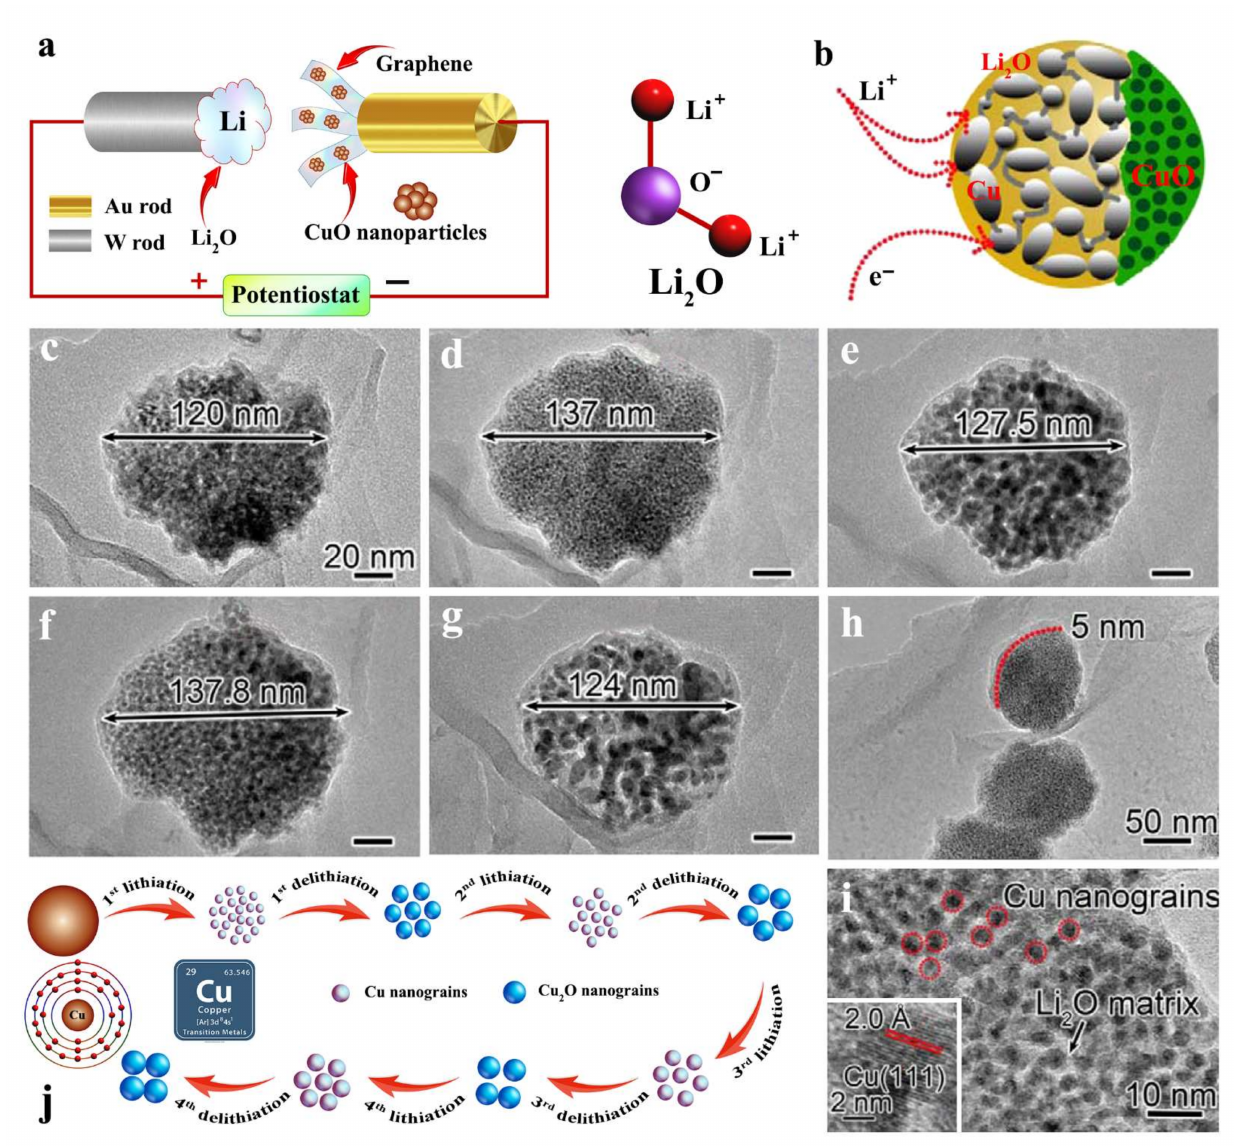
Figure 14. Morphological images of the changes occurring in pristine CuO/graphene electrode on charge–discharge cycling in a nano-LIB; ( a ) Illustration of the electrochemical setup for in situ TEM imaging, ( b ) schematic representation of the reaction front in a single CuO particle and the transport pathway for Li + ions and electrons; TEM image of ( c ) the pristine CuO nanoparticle, ( d ) the first lithiation product, ( e ) delithiated CuO nanoparticle, ( f ) the second lithiated CuO, ( g ) delithiated CuO nanoparticle ( h ) HRTEM image recorded from a lithiated CuO nanoparticle, ( i ) lithiated CuO nanopar- ticles, (red circles indicate the formation of Cu grains and the inset represents high resolution images, and ( j ) the schematic illustration of the variation in size of the CuO on lithiation/delithiation process. Adapted and reproduced with permission from Ref. [72]. Copyright 2015 American Chemical